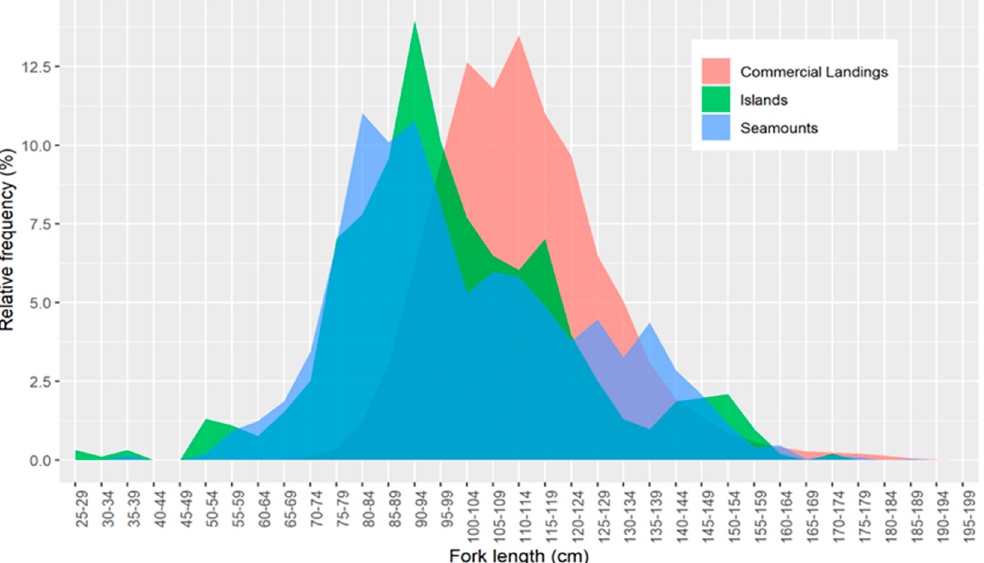
Figure 3. Relative frequency of fork length class (FL) (5 cm interval) of Lepidopus caudatus in Azorean waters, derived from the scientific survey (around the islands and seamounts) and fishery-dependent data. Commercial landings n = 29,991; Seamounts n = 1923; Islands n = 909. Lepidopus caudatus showed differences in sizes regarding the depth (Welch test; F = 28.515, p < 0.001) with a bigger–deeper trend in the Azores (Figure 4).